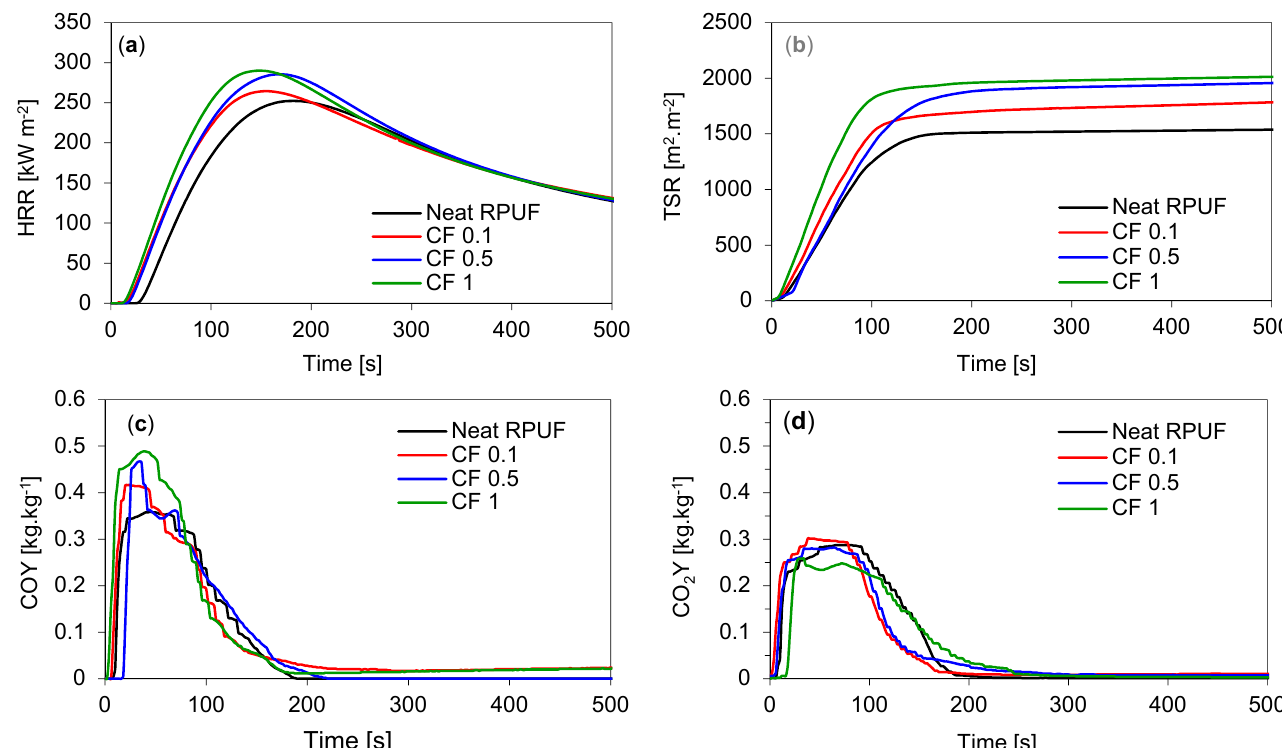
10 of 16 Table 6. Main results from the cone calorimeter tests for the studied RPUF composites. Sample